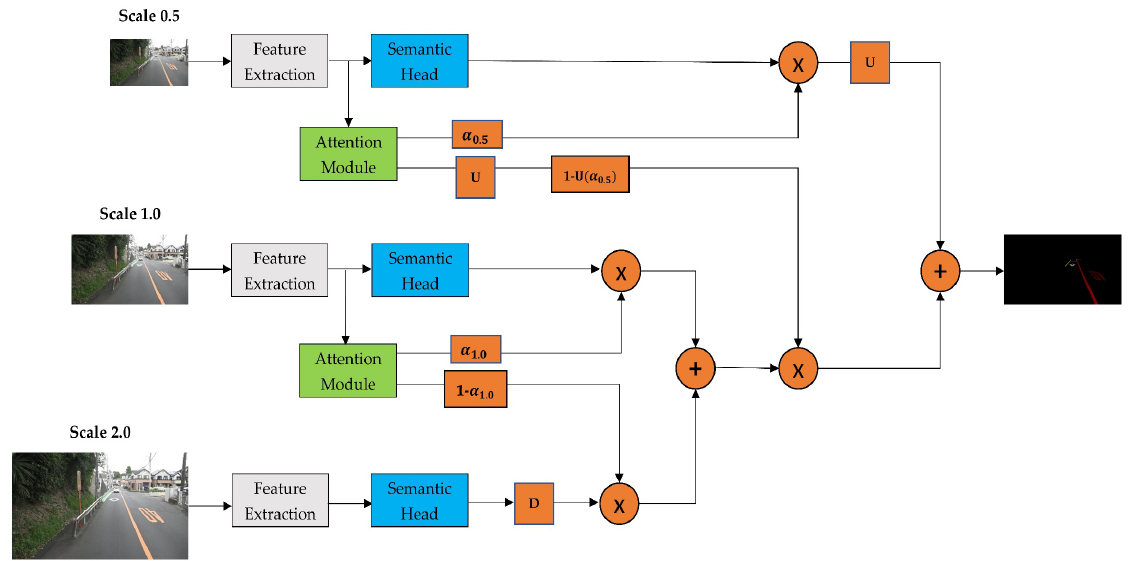
Figure 5. The procedure of the inference process of the proposed Figure 5 . The procedure of the inference process of the proposed method.